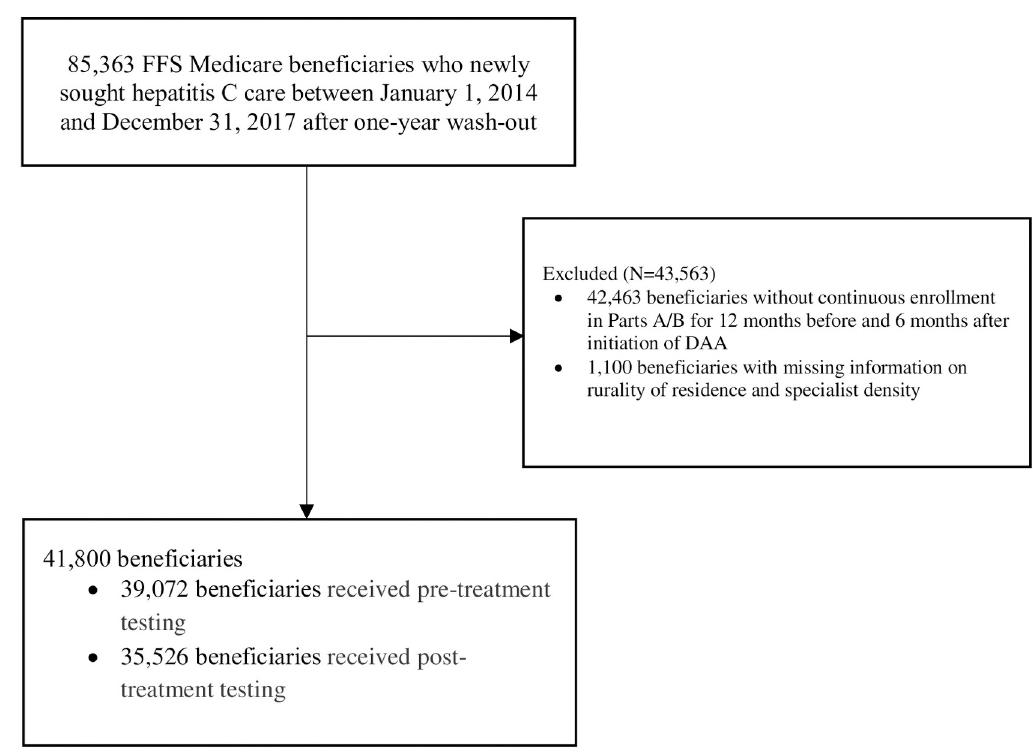
Fig 1. Study sample selection for pre- and post-treatment testing in DAA users. Abbreviations: FFS, fee-for-service.